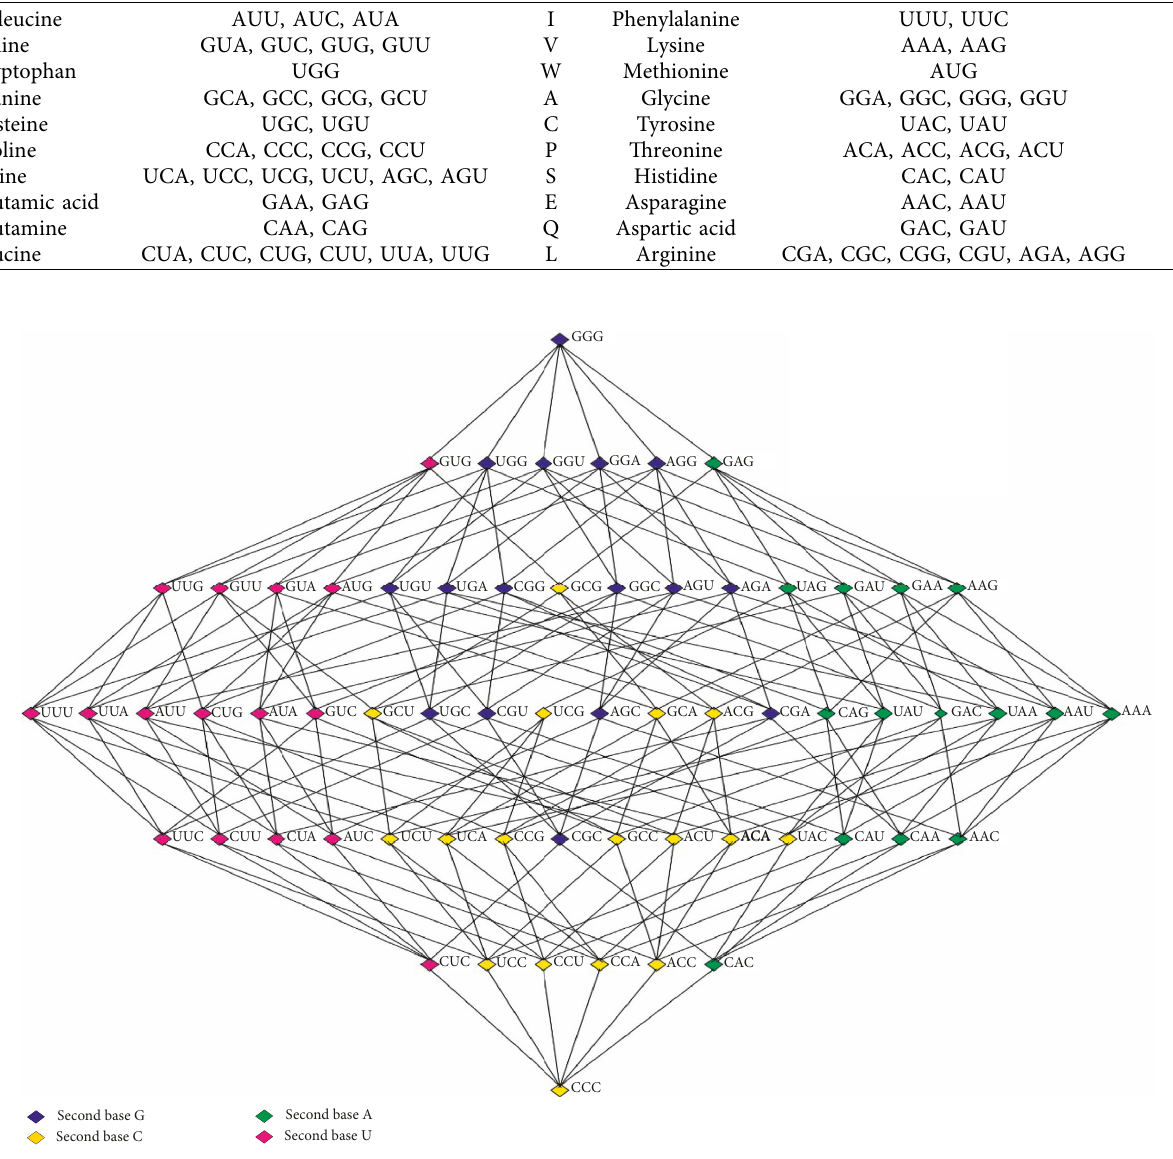
Figure 3: The Boolean lattice of 64